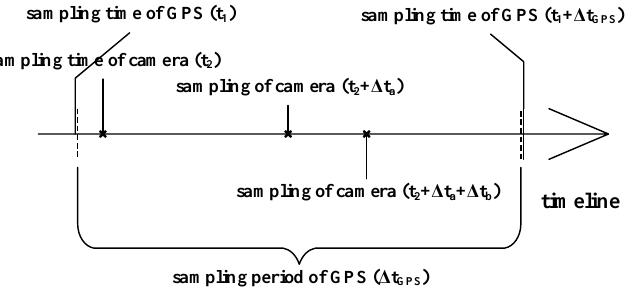
Figure 1. Multi-sensor system sampling diagram for MASS.